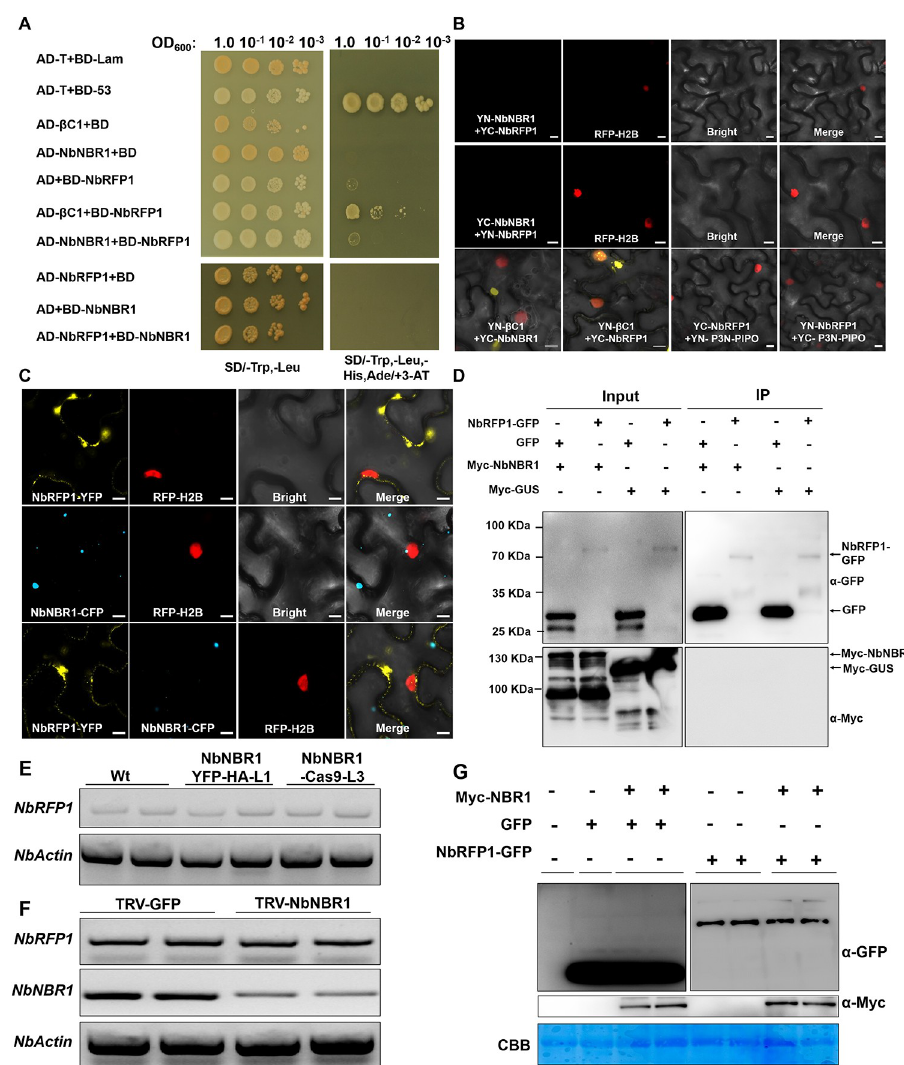
Fig 6. No direct interaction between NbNBR1 and NbRFP1, and NbNBR1 does not affect NbRFP1 mRNA and protein expressions. (A) Y2HGold cell cultures transformed with the indicated constructs were first serially diluted (1.0 to 10 − 3 ) and then grown on the SD-Trp-Leu-His-Ade medium supplemented with 10 mM 3-aminotriazole (3-AT). (B) A . tumefaciens cultures carrying the indicated constructs were individually infiltrated into the leaves of the RFP-H2B transgenic N . benthamiana plants. The infiltrated leaf cells were examined and imaged under a confocal microscope at 48 hpi. Bar = 10 μ m. (C) A . tumefaciens cultures carrying NbRFP1-YFP, NbNBR1-CFP or NbRFP1-YFP +NbNBR1-CFP were infiltrated into the RFP-H2B transgenic N . benthamiana leaves, respectively, followed by confocal microscopy. Bar = 10 μ m. (D) Co-IP assay was utilized to determine the interaction between Myc-NbNBR1 and NbRFP1-GFP. A . tumefaciens cultures carrying the indicated constructs were infiltrated into N . benthamiana leaves, respectively. Samples made before (Input) and after (IP) immunoprecipitation were analyzed through Western blot assays using anti-GFP or anti-Myc antibodies. (E, F) End point qPCR was conducted to determine the expressions of NbNBR1 and NbRFP1 in the NbNBR1-YFP-HA transgenic, NbNBR1-Cas9 mutant, or NbNBR1 -silenced plants. (G) Western blot analyses were used to determine the expression levels of Myc-NbNBR1 and NbRFP1-GFP using anti- GFP or anti-Myc antibodies. The CBB-stained Rubisco large subunit gel was used to show equal sample loadings. Each experiment was performed three